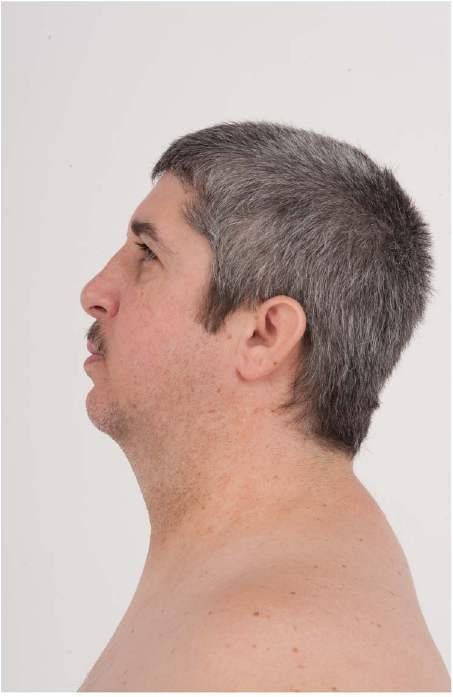
Figure 1. Frontal view of Patient 1 at age 41 years. He was originally diagnosed with Dubowitz syndrome (Opitz et al , 1973; Walters and Desposito, 1985). This is the first published photograph of this seminal patient. Exome sequencing identified compound heterozygote mutations in LIG4 , confirming the formal diagnosis of LIG4 syndrome. Dysmorphic features include microcephaly ( , 3 rd centile), bilateral downslanted palpebral fissures, low anterior hairline, and a long tubular nose with prominent bulbar tip.